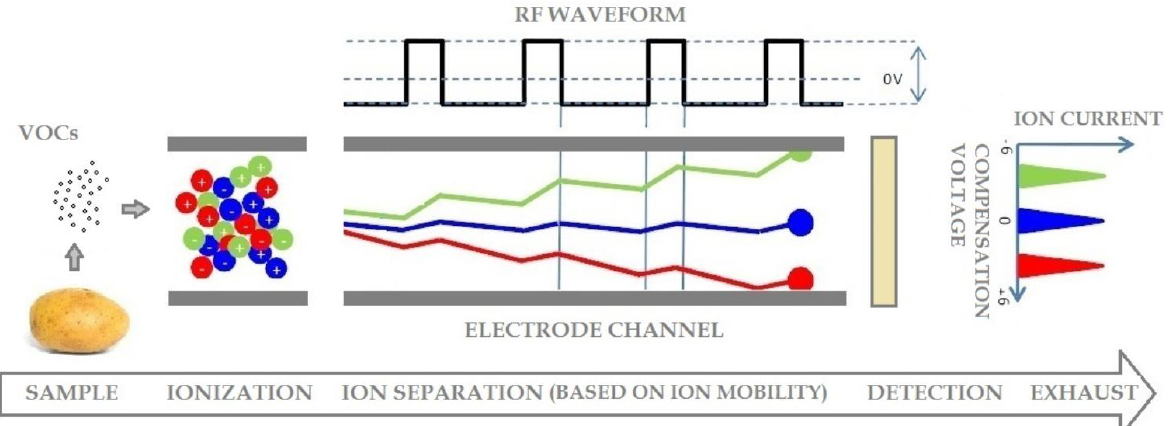
Figure 1. Basic working principle of Field Asymmetric Ion Mobility Spectrometry (FAIMS)